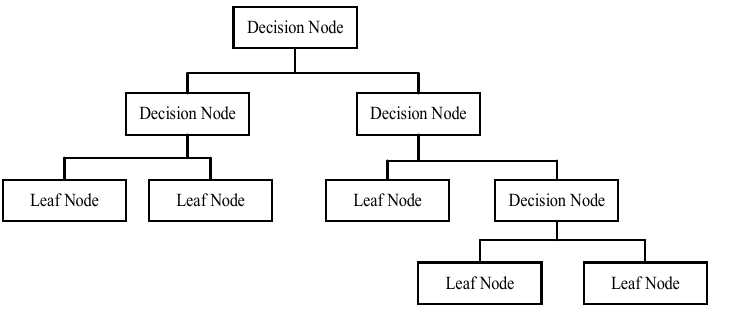
Figure 9. Decision Tree